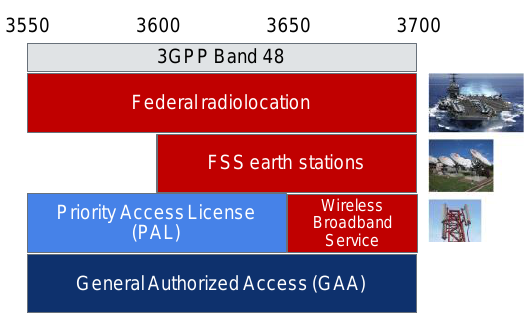
Figure 1. The US 3-tiered CBRS spectrum access model and band plan.